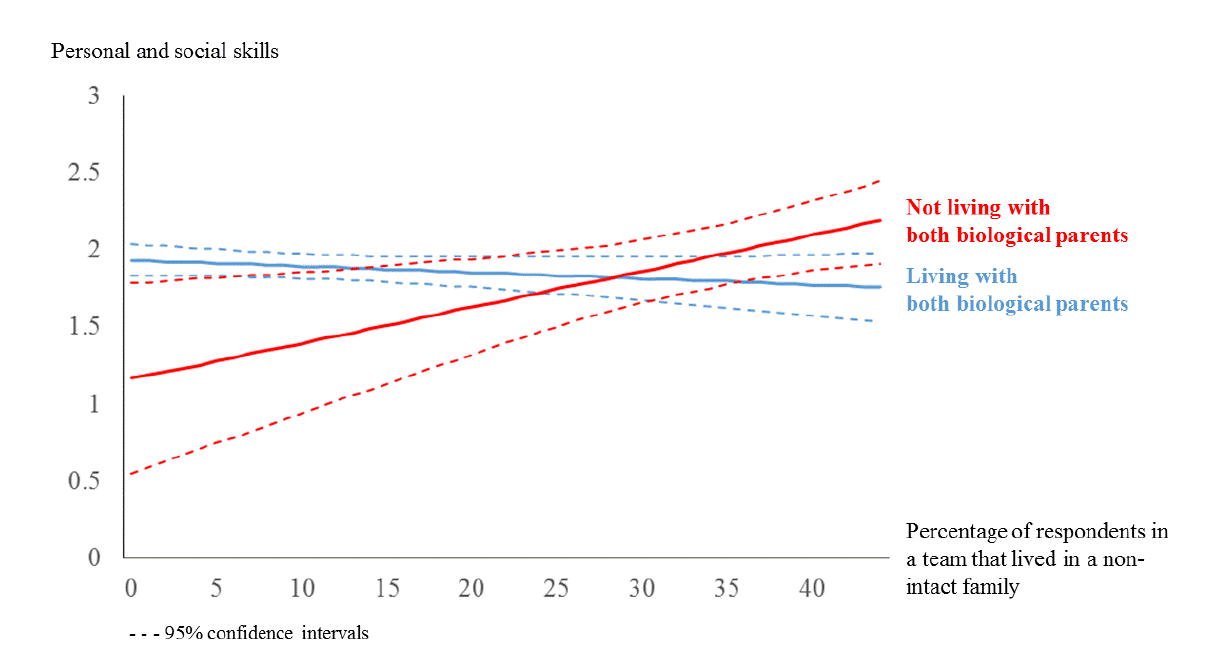
Figure 2. Interaction effect for personal and social skills between the respondents’ family structures on the participant level and team level.